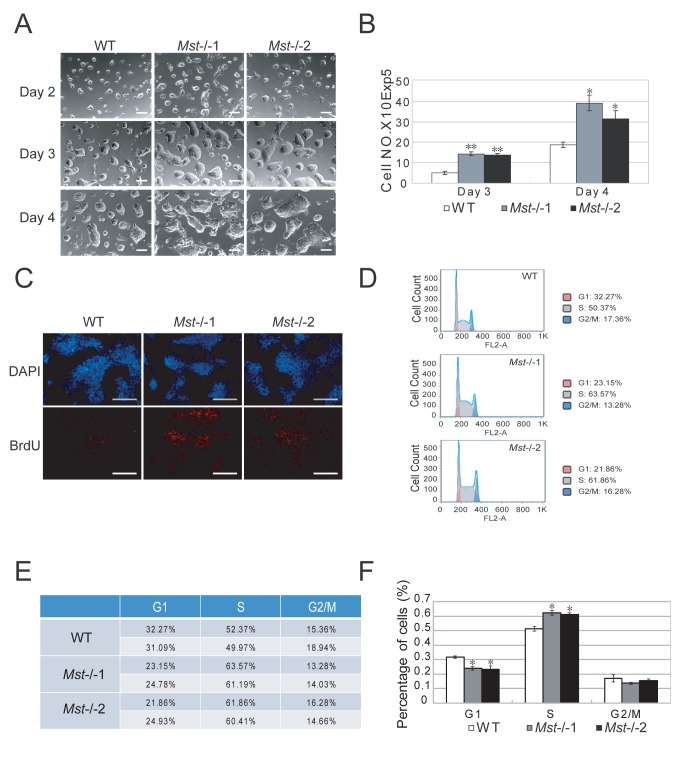

Mst-/- ES cells proliferate faster than wild type ES cells.(A) Morphology of 1x105 wild type ES cells or Mst-/- ES cells grown in 2i+LIF ES medium for 2 days, 3 days and 4 days respectively. Scale bar, 200 μm. (B) Statistical analysis of the growth rate of wild type ES cells and Mst-/- ES cells on day 3 and day 4 culture. The data were shown as the mean ± S.D (n=3). Statistically significant differences are indicated (*, P<0.05; **, P<0.01; ***, P<0.001). (C) Immunofluorescence staining with BrdU antibodies to examine BrdU integration in wild type ES cells and Mst-/- ES cells after serum starvation for 12 hours. Cells are pulsed labeled with BrdU for 45 minutes. The nuclei were stained with DAPI. Scale bar, 200 μm. (D) Representative histograms of cell cycle distribution in Mst-/- ES cells and wild type ES cells. (E) Table of the cell cycle distribution in Mst-/- ES cells and wild type ES cells from two independent experiments. (F) Statistical analysis of cell cycle distribution in Mst-/- ES cells and wild type ES cells from two independent experiments. (*, P<0.05).